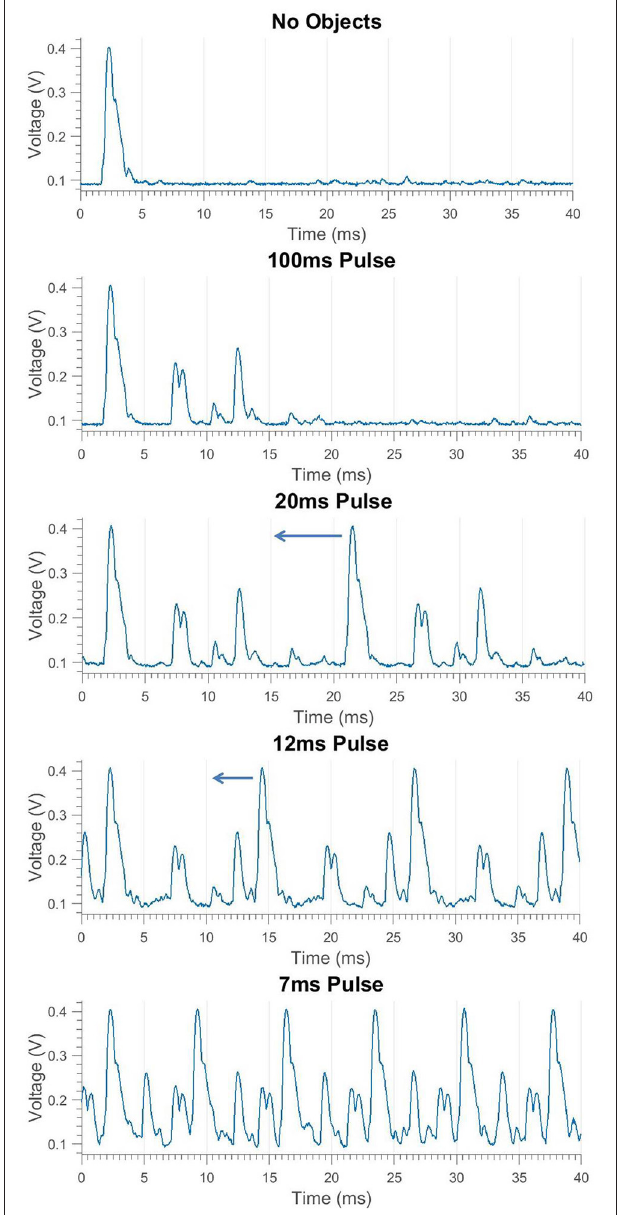
FIGURE 3 | Aliasing visualized. In this cartoon example, each timeline has pulses (represented by tall lines) and received echoes (represented by shorter lines). Each pulse and its echoes are given a unique color. From top to bottom, the interpulse interval decreases until a new pulse occurs before all echoes from the previous pulse are received, shown in the bottom timeline. The echo is misinterpreted as a closer object associated with the latest pulse. This is the aliased echo, and is labeled with an asterisk.